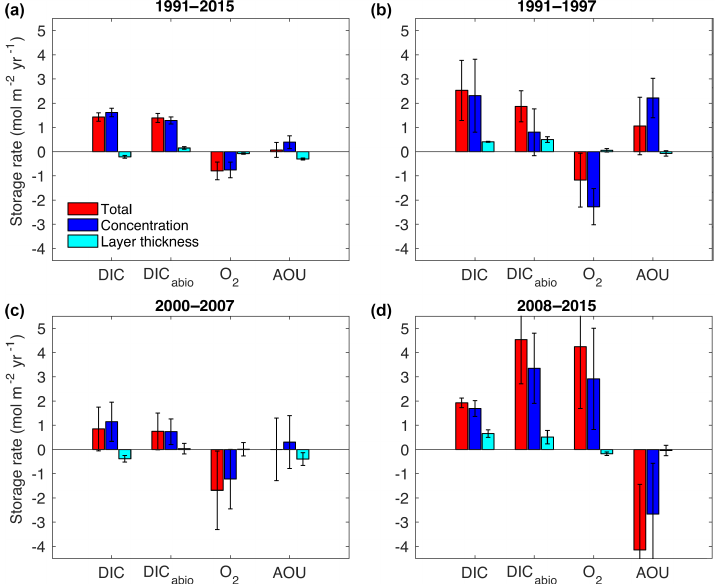
Figure 10. Decomposition of the total storage rates (red bars) into the concentration-driven storage rate (blue bars) and the layer-thickness- driven storage rate (cyan bars) for DIC, DIC abio , O 2 and AOU from (a) 1991–2015, (b) 1991–1997, (c) 2000–2007 and (d) 2008–2015. The error bars represent the error of the linear regression